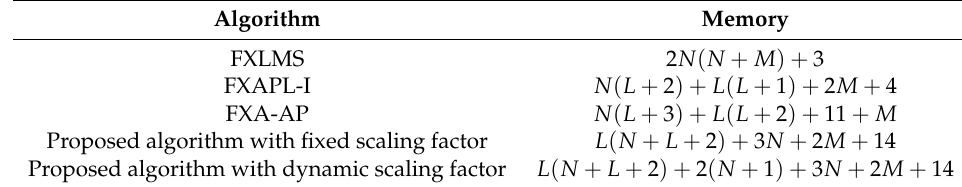
Table 3. Memory requirements for the FXLMS, FXAPL-I, FXA-AP and the proposed algorithm for single-channel ANC